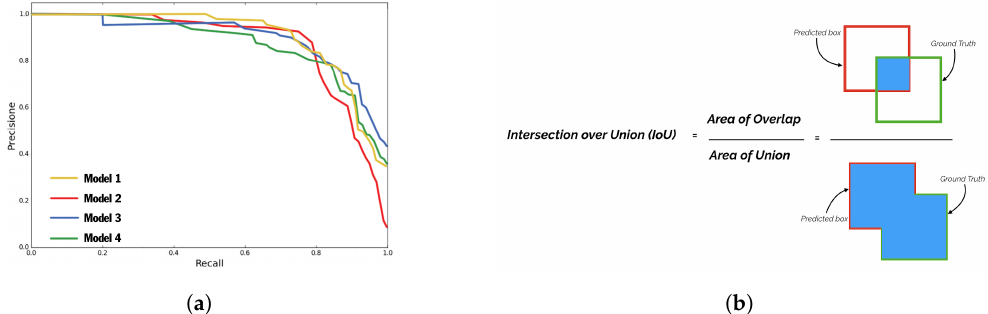
Figure A1. Illustration for ( a ) precision, recall curve and ( b ) IoU. F1-score, area under the curve (AUC), and average precision (AP) are the most pre- ferred metrics for this purpose (Figure A2). The F1-score is the harmonic means of precision and recall at a specific confidence level, used to find the optimal confidence threshold where precision and recall produce the highest F1 value. AUC integrates the amount of the plot that falls underneath the precision and recall curve by measuring the area